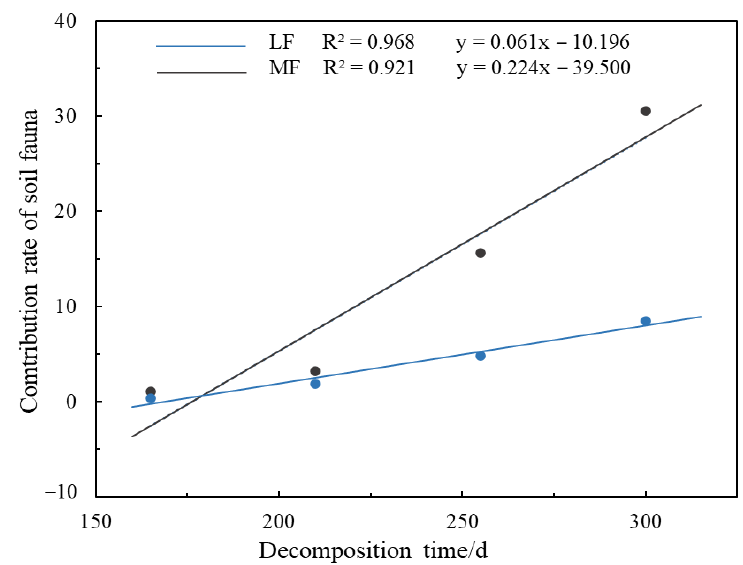
Figure 8. Contributions of soil fauna to litter decomposition.